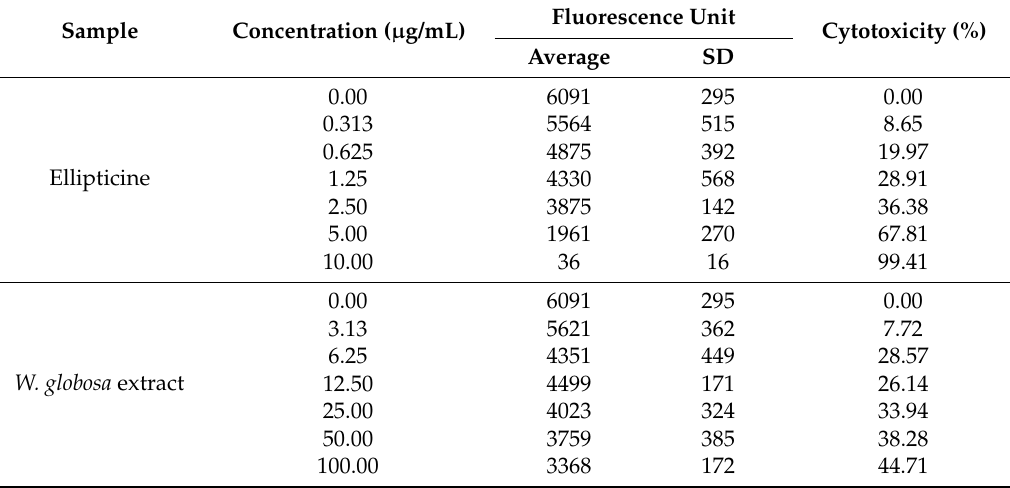
Table 2. Cytotoxicity study of W. globosa crude extract and ellipticine on human dermal fibroblast neonatal (HDFn) cell line.